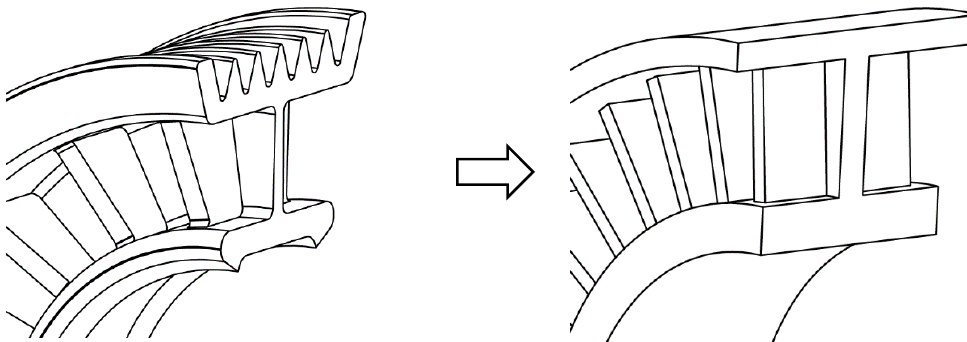
Figure 4. Simplification of the pulley structure.